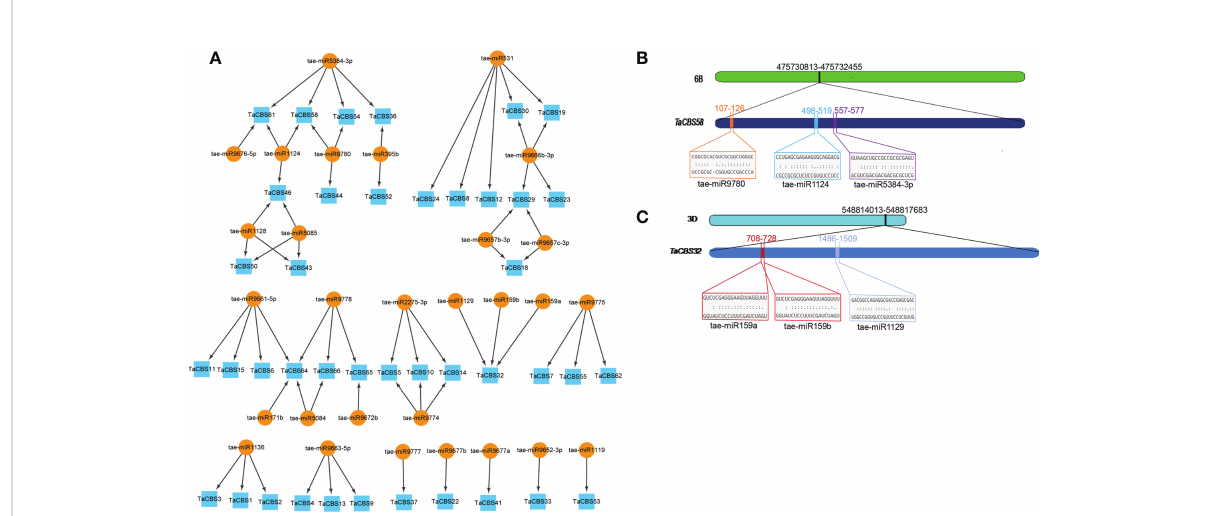
FIGURE 9 miRNAs targeting TaCBS genes in wheat. (A) miRNA target network map for TaCBS genes, with indigo boxes corresponding to TaCBS genes and brownish yellow round shapes corresponding to predicted miRNAs. (B) It is evident from the graphic illustration that the TaCBS58 gene is targeted by miRNAs (tae-miR9780, tae-miR1124, and tae-miR5384-3p). (C) There are three miRNAs that target the TaCBS32 gene (tae-miR159a, tae-miR159b, and tae-miR1129) illustrated in this graphic. 6B and 3D represent chromosomes. TaCBS58 and TaCBS32 represent the location of miRNAs on gene sequence. Color boxes indicate the RNA sequences of the complementary sites 5 ’ to 3 ’ and the predicted miRNA sequences 3 ’ to 5 ’ in Figures 9B, C. The complete dataset of predicted miRNAs is presented in Supplementary Table 10.